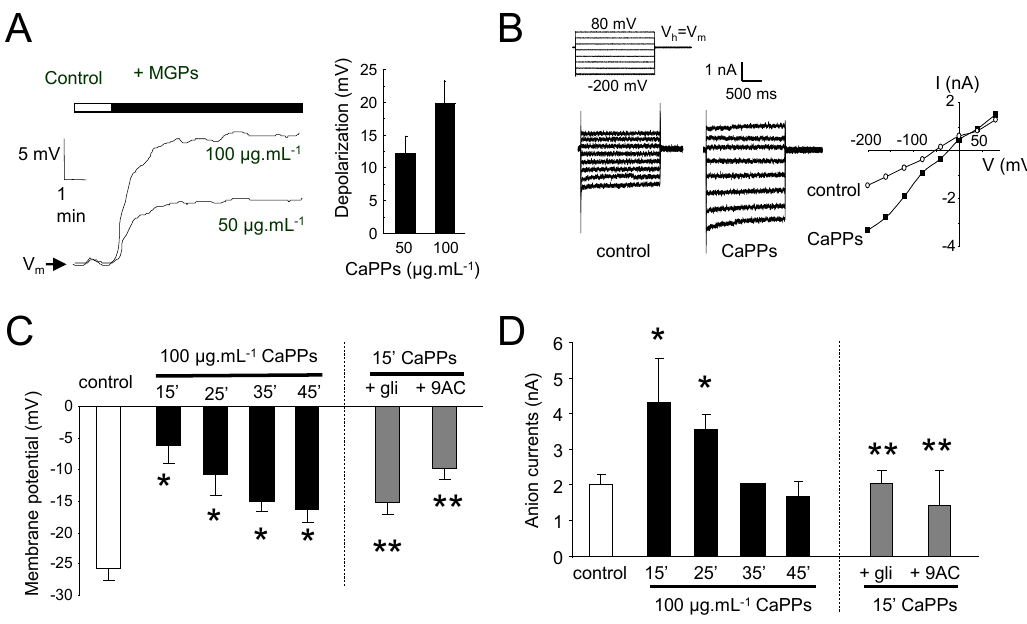
Figure 4. CaPP-induced depolarization and anion current increase in BY-2 cells. ( A ). Typical depolarizations of BY-2 cell observed in response to CaPPs at 50 or 100 µ g.mL − 1 and mean values